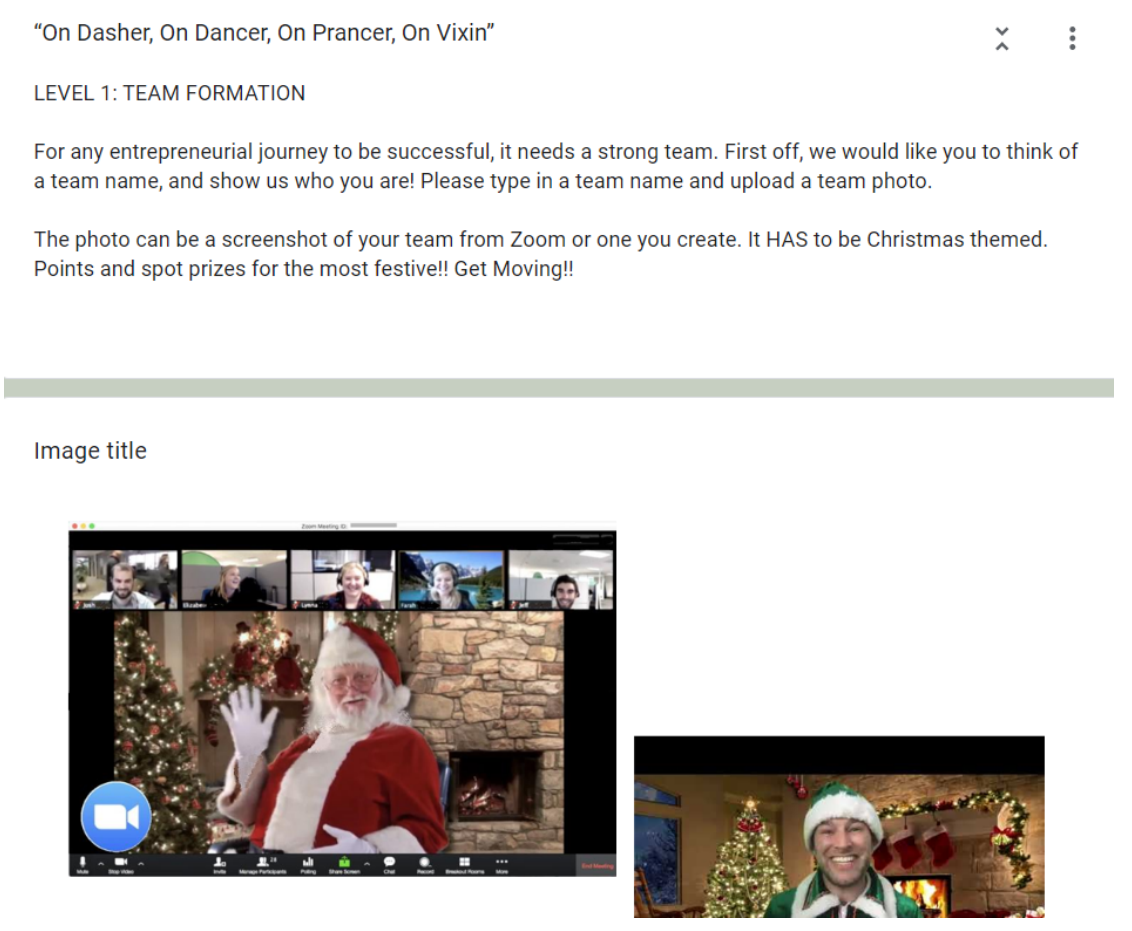
Figure 2. Level One of the “LIFE” Escape